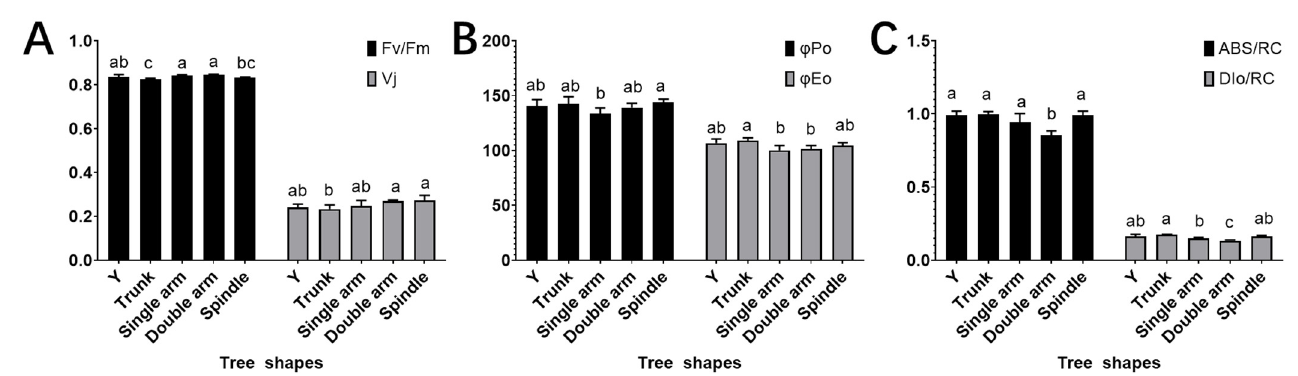
Figure 4. The effects of different tree shapes of Zaosu pear on the chlorophyll fluorescence parameters ( A ), quantum yield ( B ), and activity of the PSII reaction centre ( C ). The error bars represent the standard deviation (SD). The lowercase letters indicate statistically significant ( p < 0.05) differences between tree shapes.